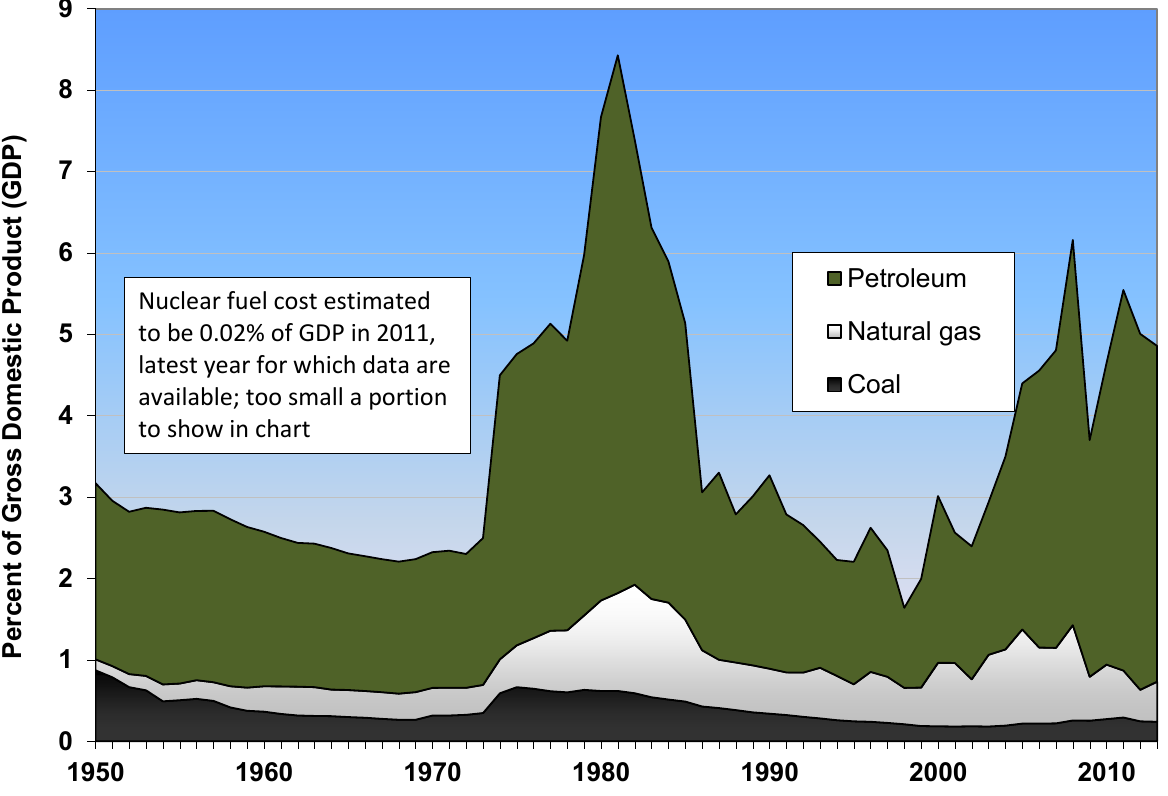
Figure 2. U.S. fuel expenditures as percent of GDP (energy cost share), 1950 through